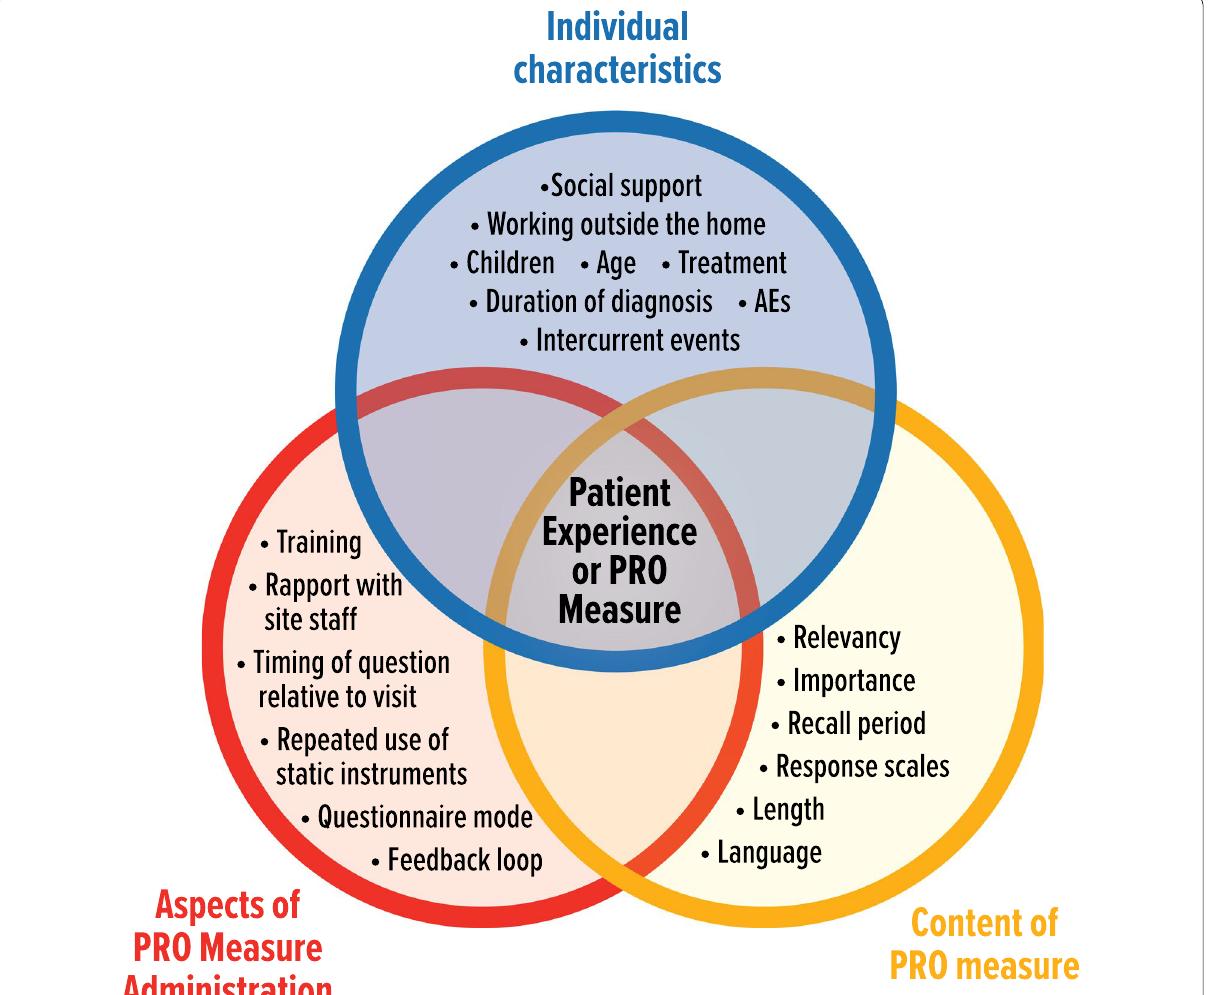
Fig. 1 Factors of external validity and meaningfulness of the patient experience with PRO measures. AE adverse event, PRO patient-reported